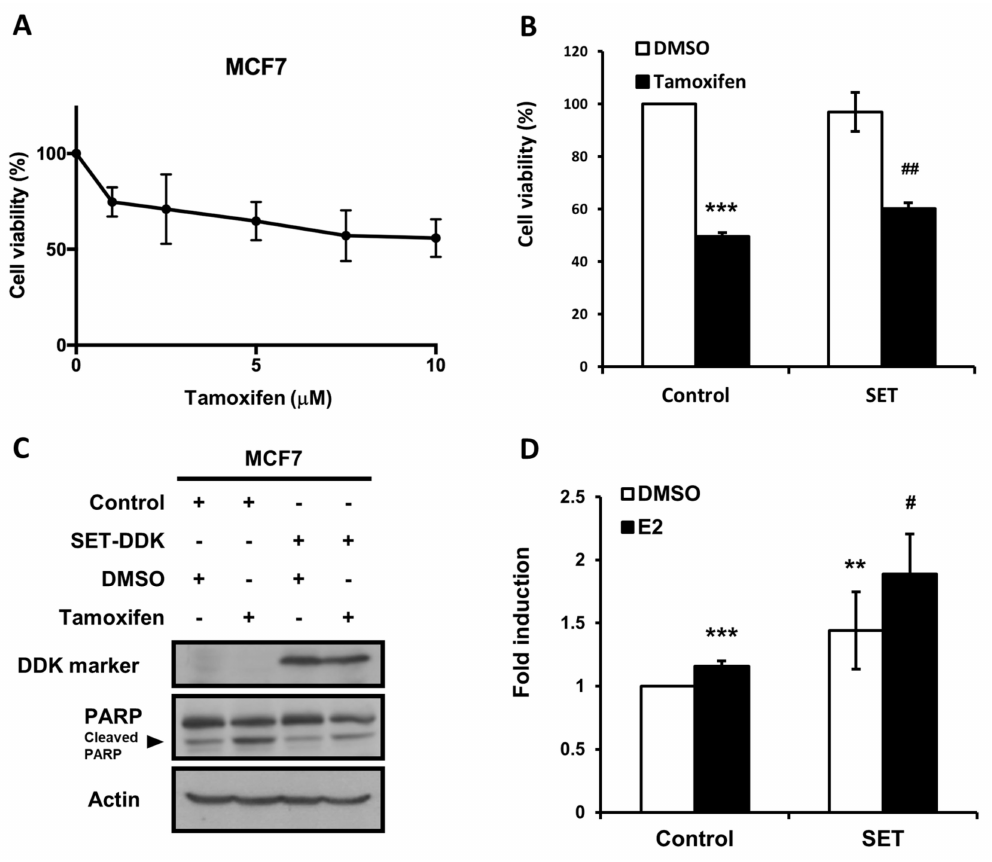
Figure 4. The overexpression of SET reduced tamoxifen-induced anti-proliferation and enhanced estrogen-promoted transactivation in the MCF7 cells. ( A ) 3-(4,5-dimethylthiazol-2-yl)-2, 5-diphenyltetrazolium bromide (MTT) assay showing that tamoxifen exerts anti-proliferative effects in the MCF7 cells in a dose-dependent manner. ( B ) MTT assay showing that SET overexpression downregulated the anti-proliferative effects after the tamoxifen treatment. *** p < 0.001 compared with cells transfected with pCMV6-Entry control plasmids and treated with DMSO. ## p <0.01 compared with cells transfected with the SET expression plasmid and treated with DMSO. ( C ) Western blot showing that SET overexpression reduced poly (ADP-ribose) polymerase (PARP) cleavage after the tamoxifen treatment. ( D ) Estrogen receptor element (ERE)-dependent transactivation showing that SET overexpression enhanced the expression of reporter assay. ** p < 0.01, *** p < 0.001 compared with cells transfected with pCMV6-Entry (control) and treated with DMSO. # p < 0.05 compared with cells transfected with the SET expression plasmid and treated with estradiol